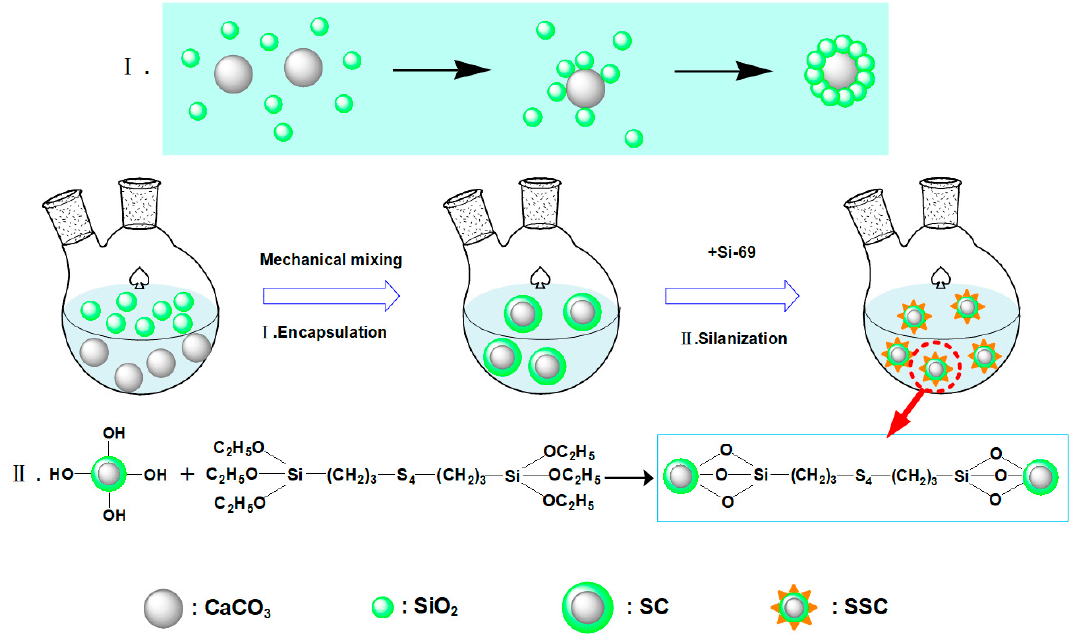
Figure 1. Schematic diagram for the preparation process and mechanism of silanized silica-encapsulated calcium carbonate (SSC) .